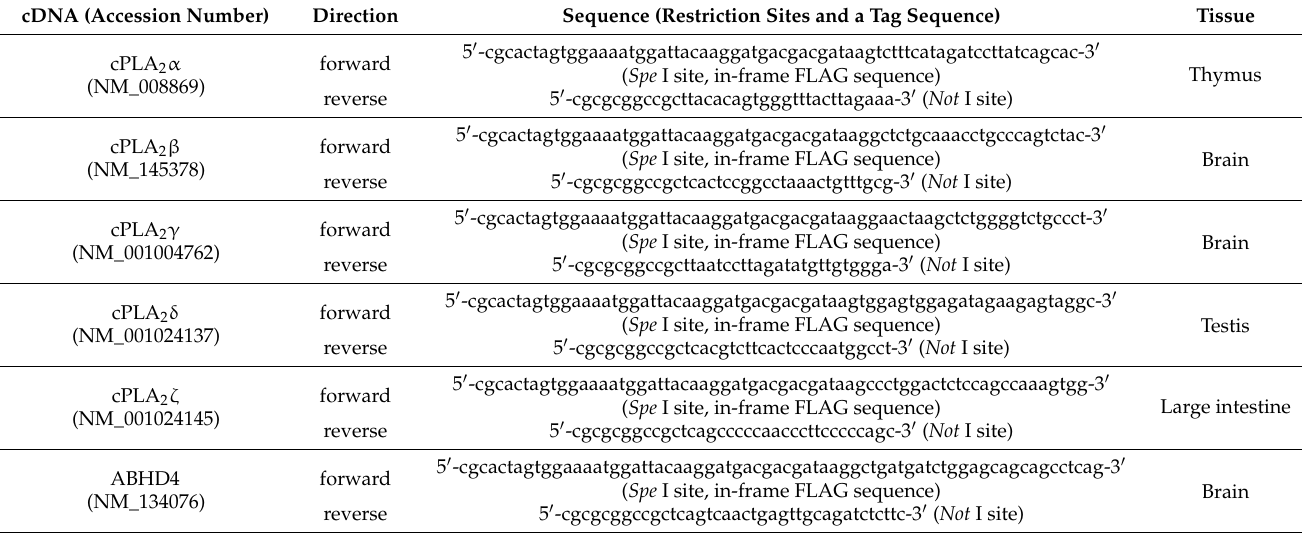
Table 1. Primers and mouse tissues used for the construction of expression